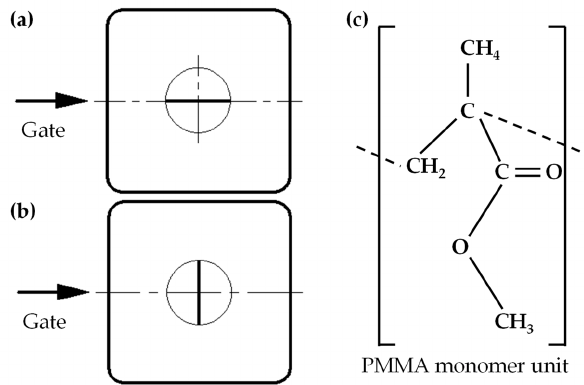
Figure 2. Longitudinal microstructure and transverse microstructure. ( a ) Length direction of the longitudinal microstructure parallel to the polymer-melt filling direction in the cavity and ( b ) length direction of the transverse microstructure perpendicular to the polymer-melt filling direction in the cavity. ( c ) Schematic of molecular structure of PMMA.